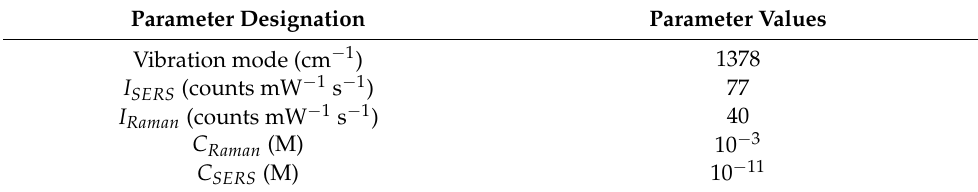
Table 1. Parameters for the calculation of AEF using Equation